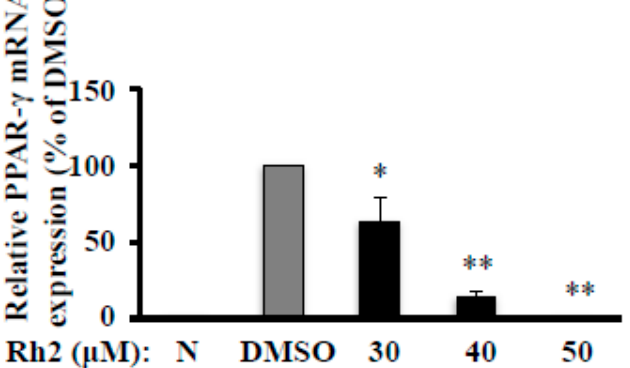
Figure 3. Ginsenoside Rh2 reduces PPAR- γ mRNA expression in 3T3-L1 cells. On day 7, cells treated with various concentrations of Rh2 were collected to measure PPAR- γ mRNA expression by quantitative real-time polymerase chain reaction (PCR) and normalized by β -actin expression. Values are means ± SE, n = 3. * p < 0.05, ** p < 0.01 vs. DMSO.